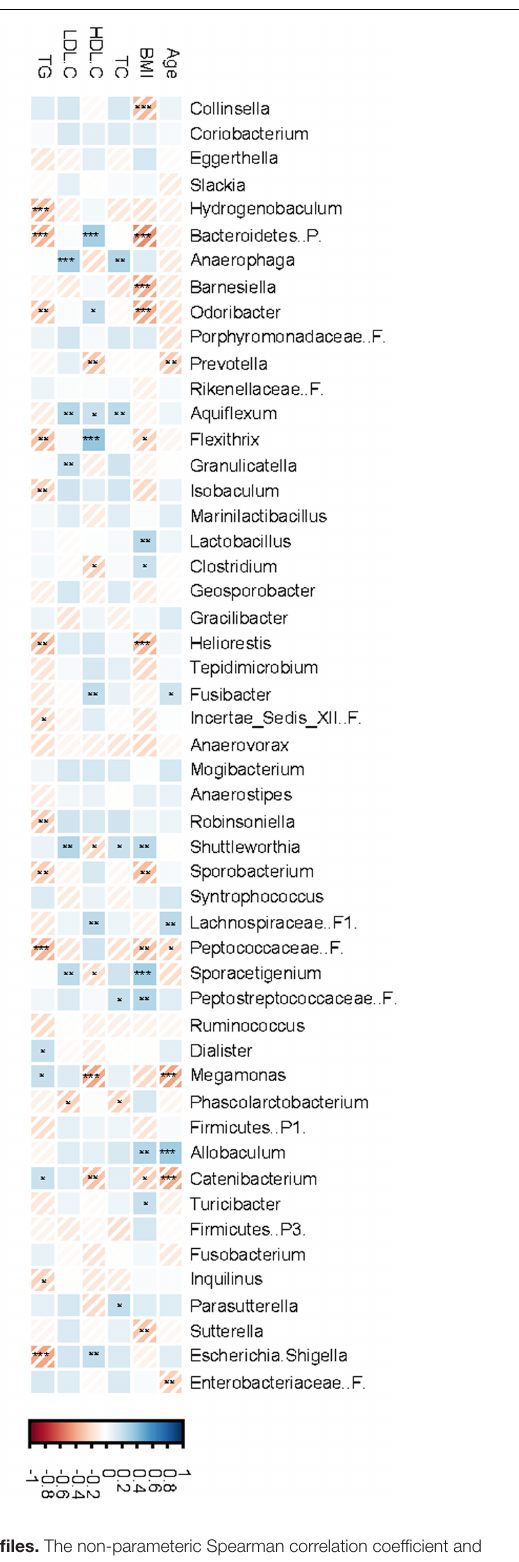
Frontiers in Microbiology |